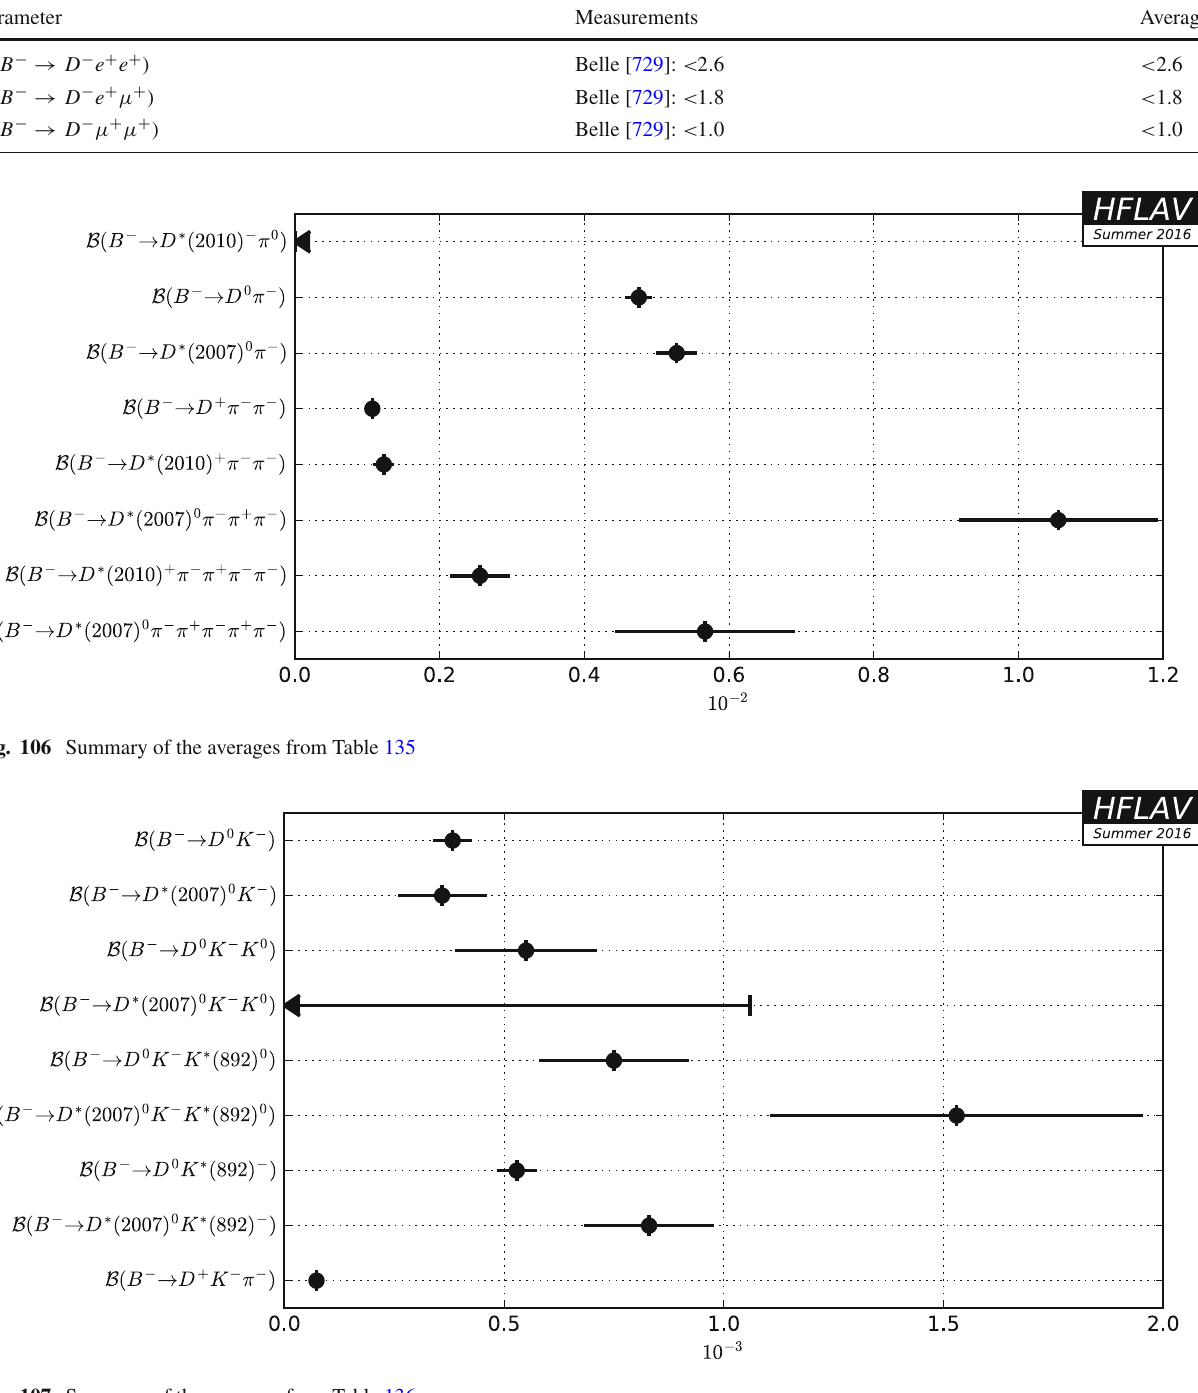
Fig. 107 Summary of the averages from Table